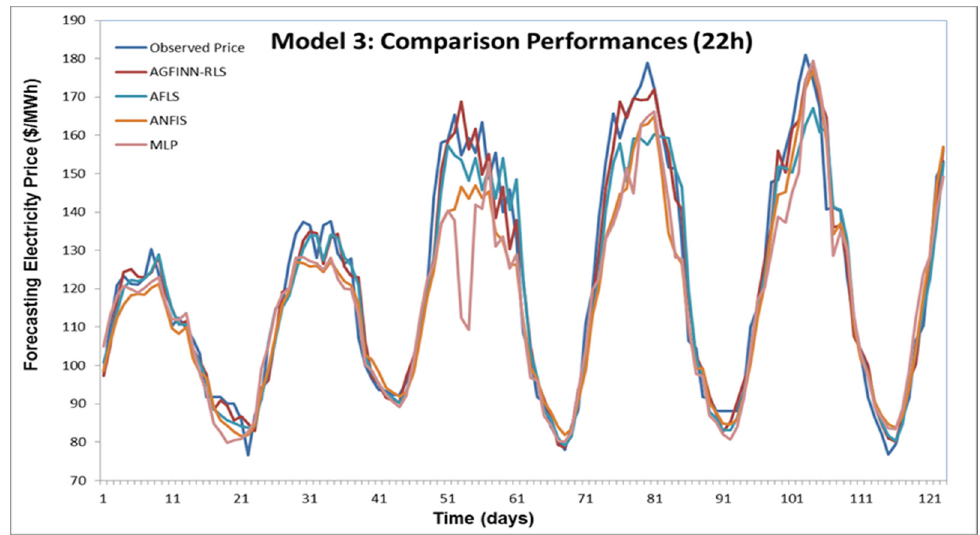
Figure 11. Prediction for electricity price at 22:00—case study 3. Energies 2019 , 12 , x FOR PEER REVIEW